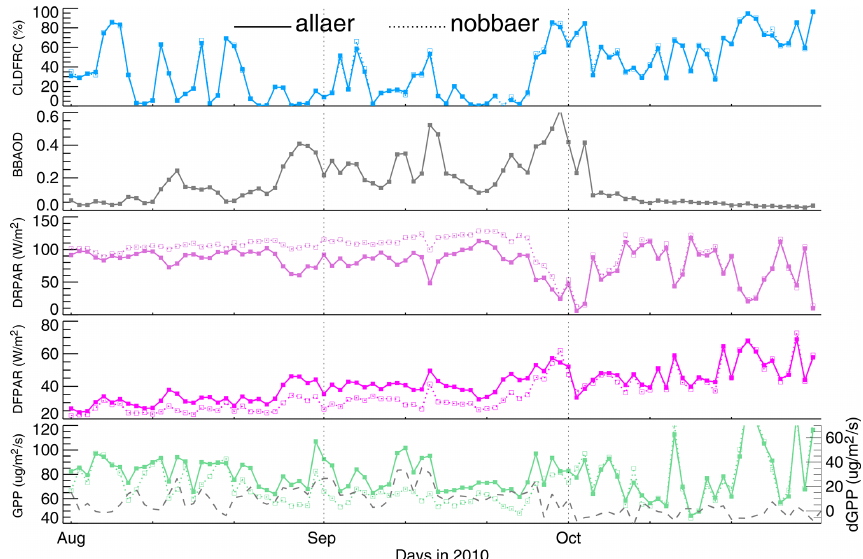
Figure 10. GEOS simulated daily values of total cloud fraction (CLDFRC, %), biomass burning AOD (BBAOD), direct PAR (DRPAR, Wm − 2 ), diffuse PAR (DFPAR, Wm − 2 ), and gross primary growth (GPP, µgm − 2 s − 1 ) from the two experiments of pair1 at a selected site (15 ◦ S, 54 ◦ W; marked with a diamond in Fig. 11) during August–October 2010. The gray dashed line in the bottom panel shows the absolute GPP difference (dGPP) between allaer and